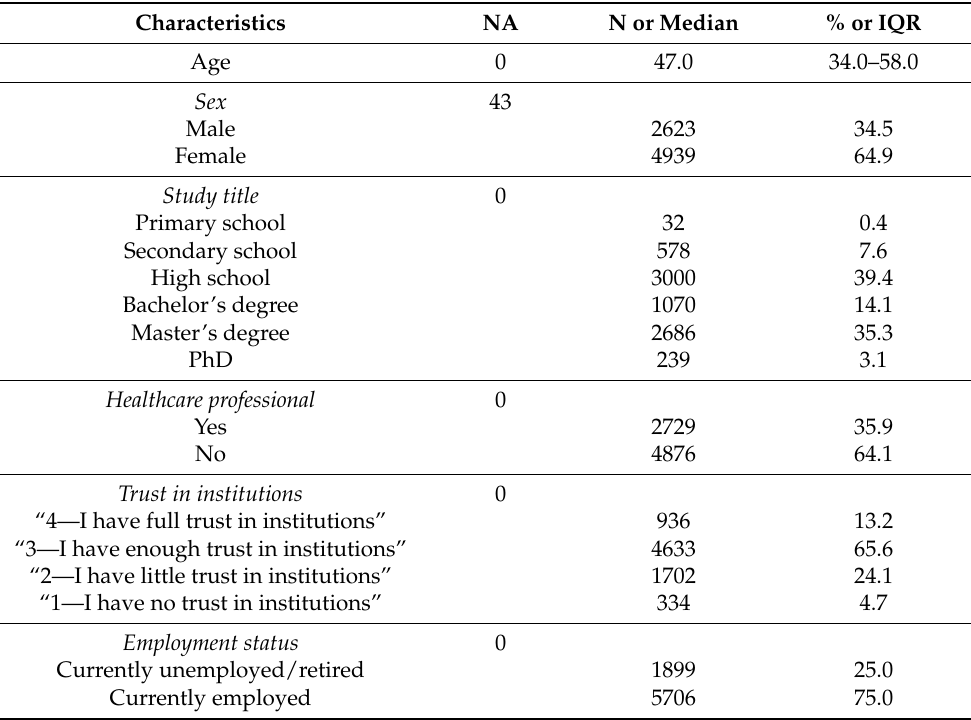
Table 1. Sociodemographic characteristics of the study participants.